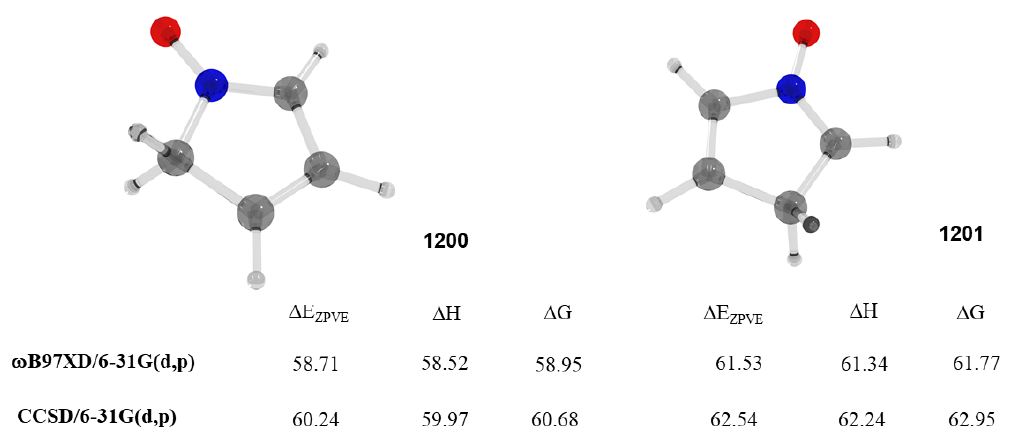
Figure 5. Optimized structures of the bipolar compounds 1200 and 1201 (CCSD/6-31G(d,p)), and their relative thermodynamic parameters (kcal/mol) in both levels of theory.